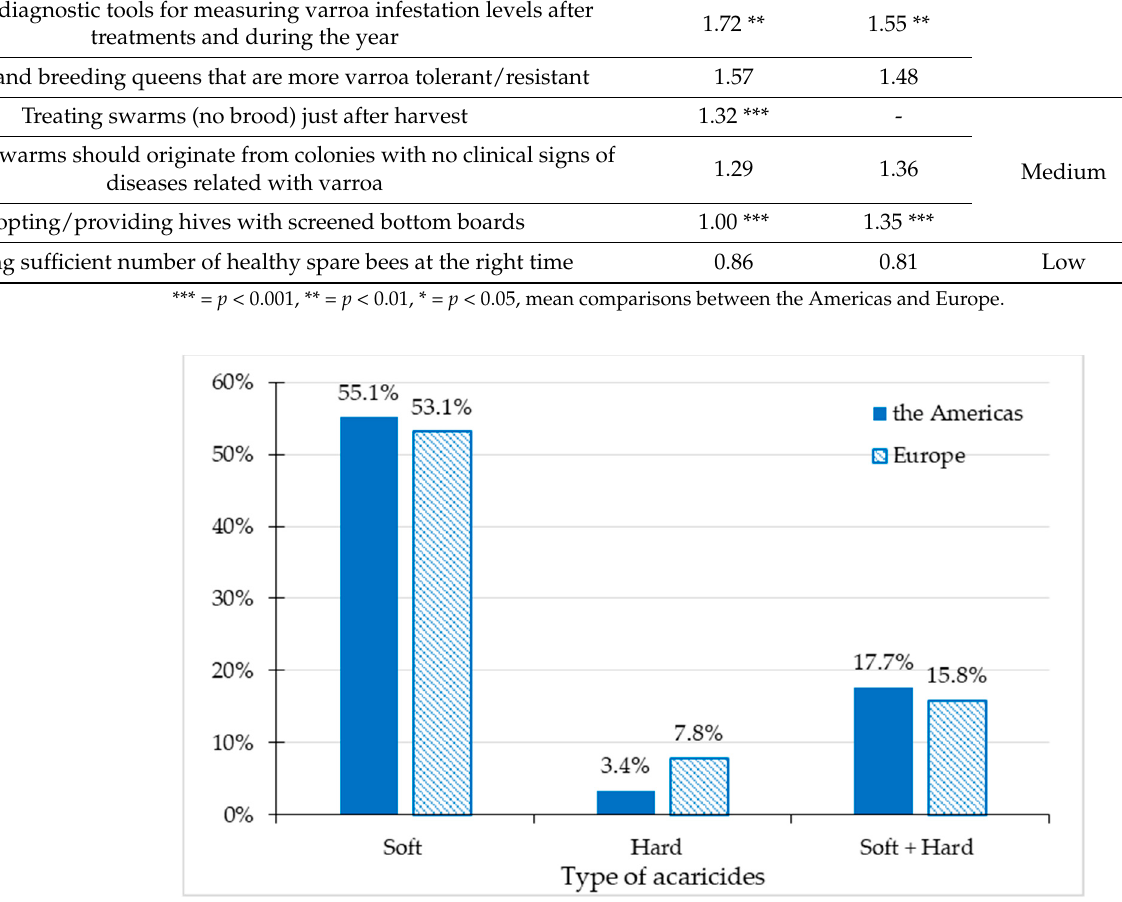
Figure 2. Percentages of use of “Soft” and “Hard” acaricides from respondents both in the Americas and in Europe to treat varroa .